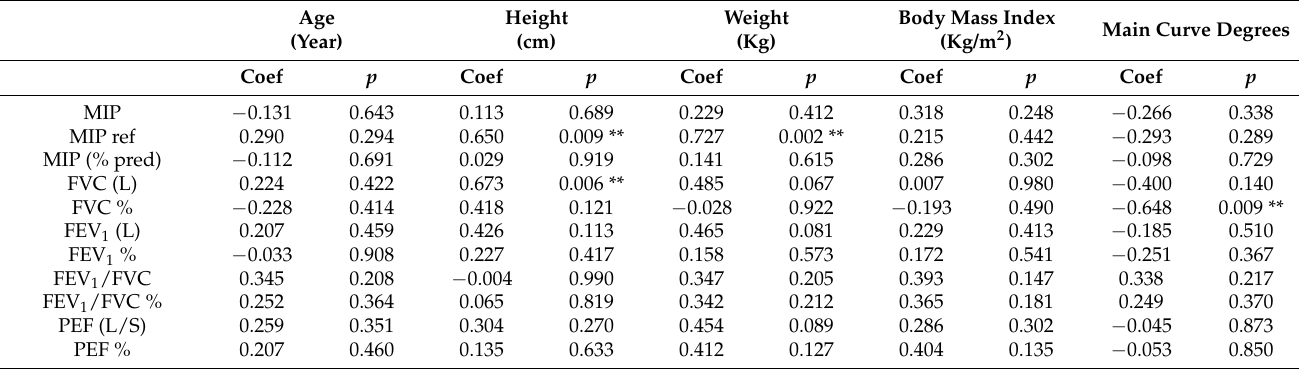
Table 2. Pearson-R correlation between respiratory parameters and morphological and sociodemographic